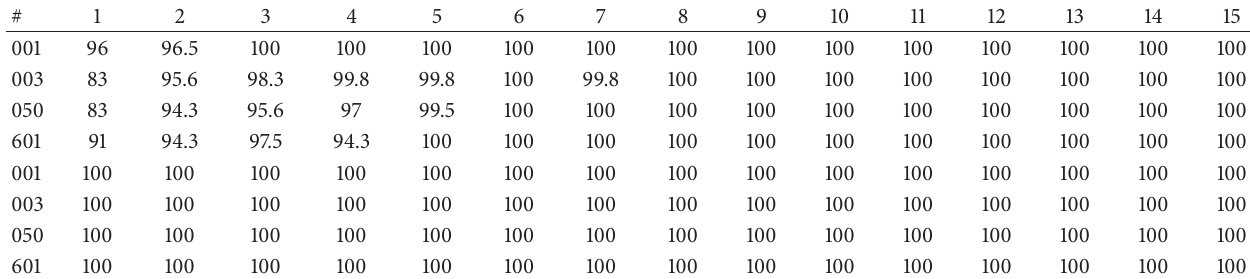
Figure 7: Bit error rates result against pixel manipulation attack. Table 13: Bit error rates result on Gaussian noise attack.